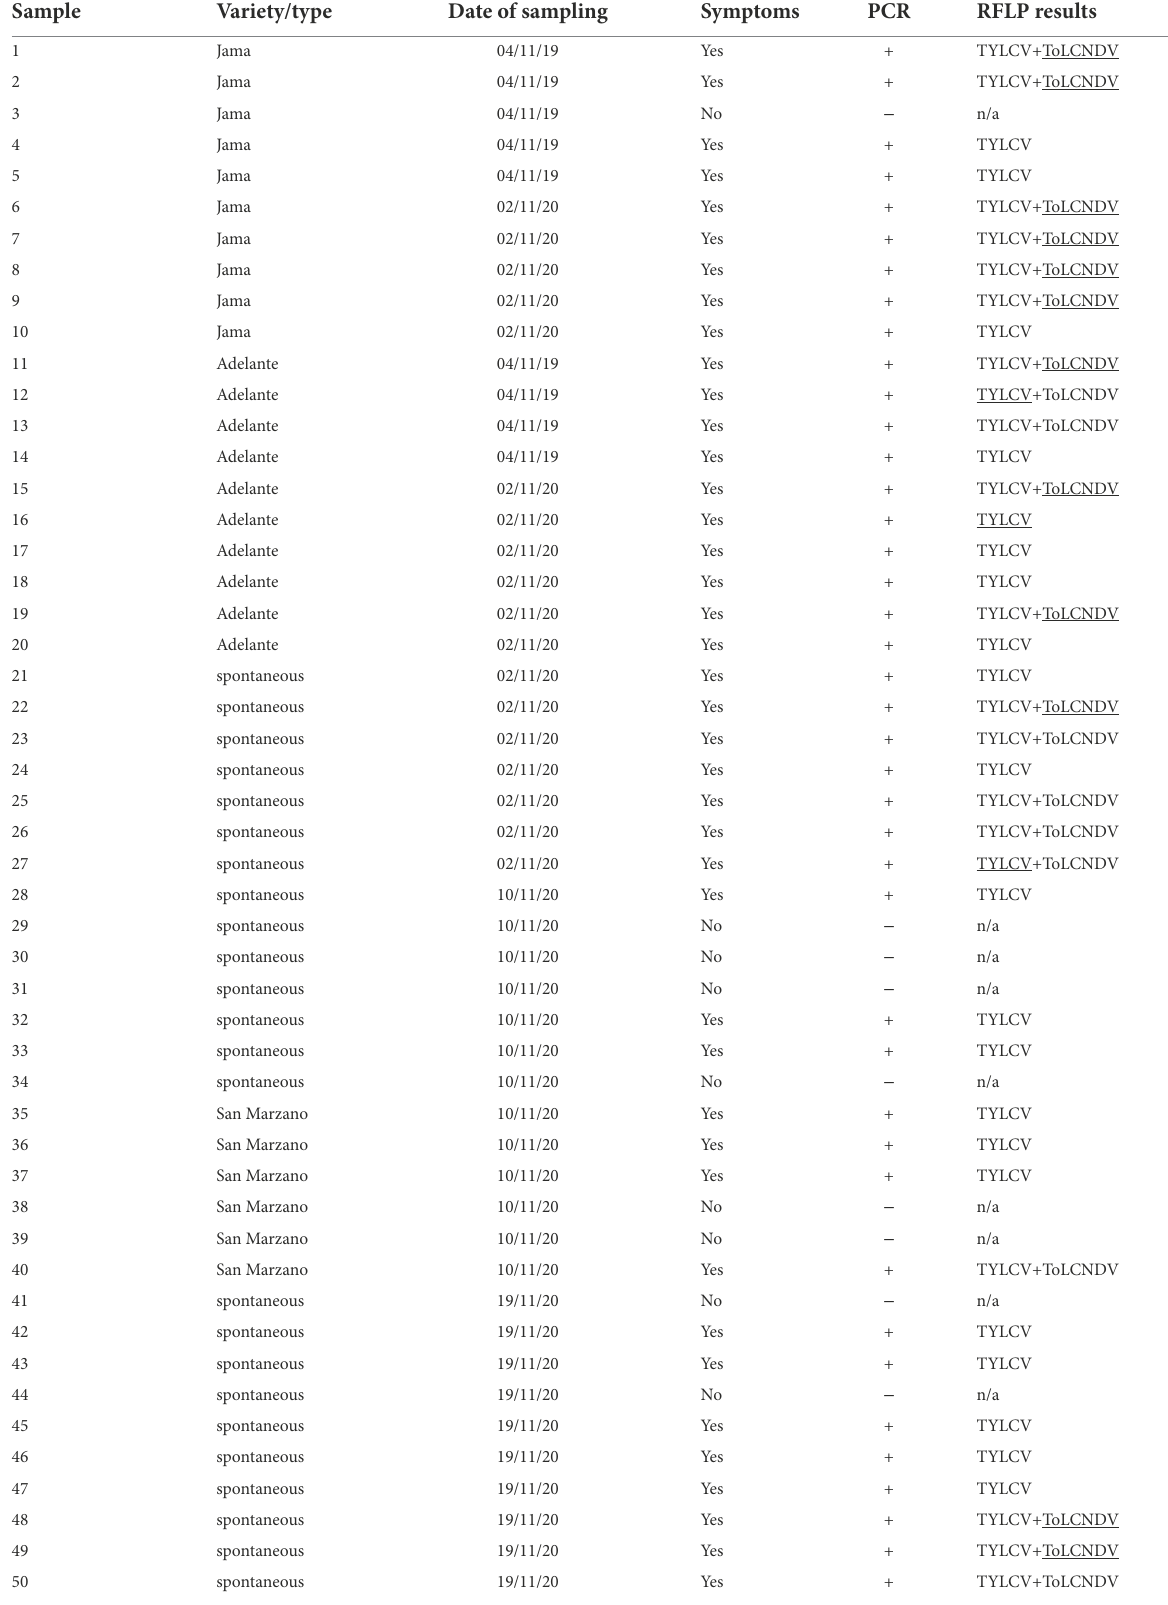
TABLE 1 Synthesis of the results obtained performing the PCR-RFLP on the DNA extracted from 71 tomato plants in cultivation or spontaneously born among zucchini plants.